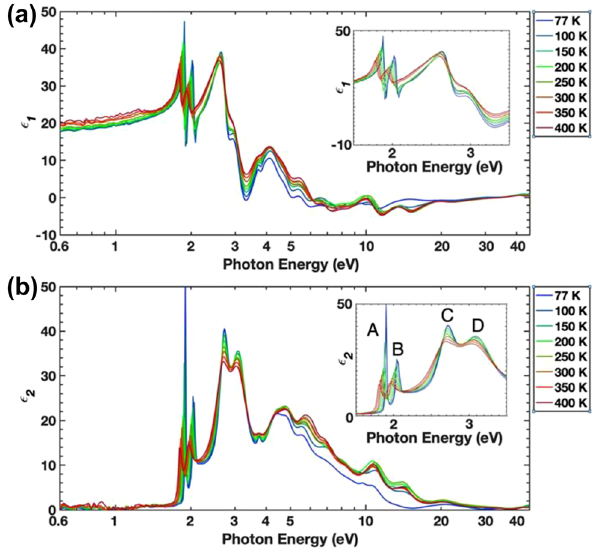
Figure 7: Ultrabroad band spectroscopic ellipsometry using synchrotron radiation.